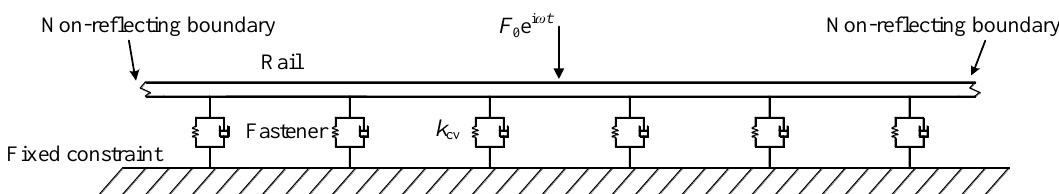
Figure 2. The Timoshenko-beam track model.